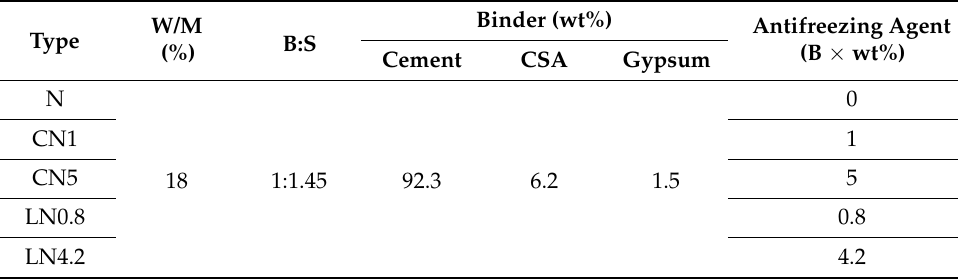
Table 4. Properties of the cement–paste